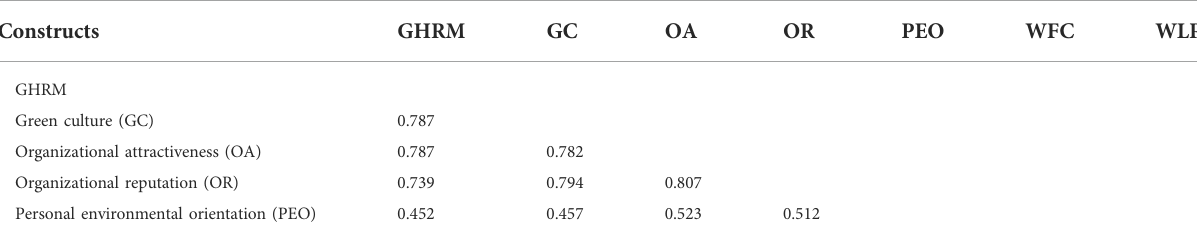
TABLE 3 Discriminant validity.